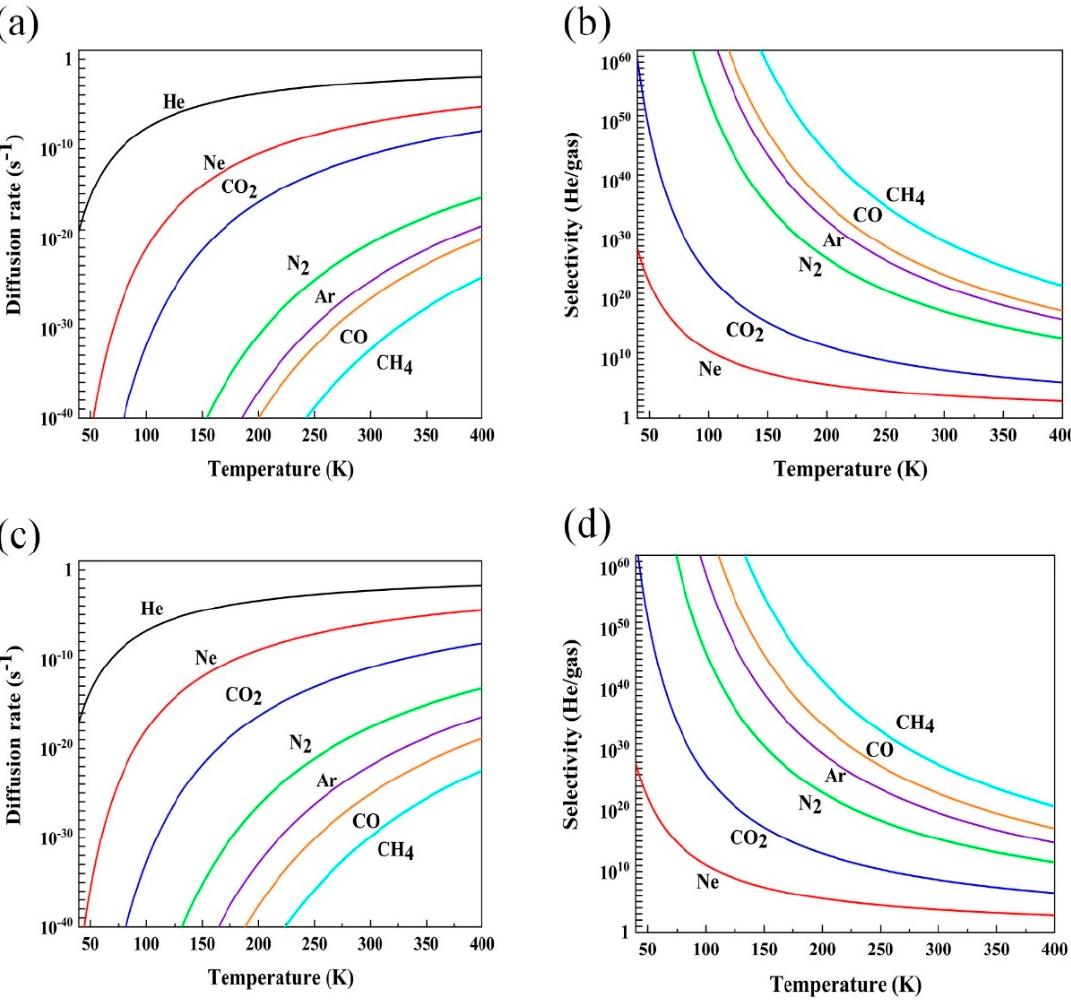
Figure 3. ( a ) The diffusion rates and ( b ) the selectivity for gases to pass through the Fe-PTC membrane as a function of temperature; ( c ) The diffusion rates and ( d ) the selectivity for gases to pass through the Ni-PTC membrane as a function of temperature. Different colors denote different gas molecules.